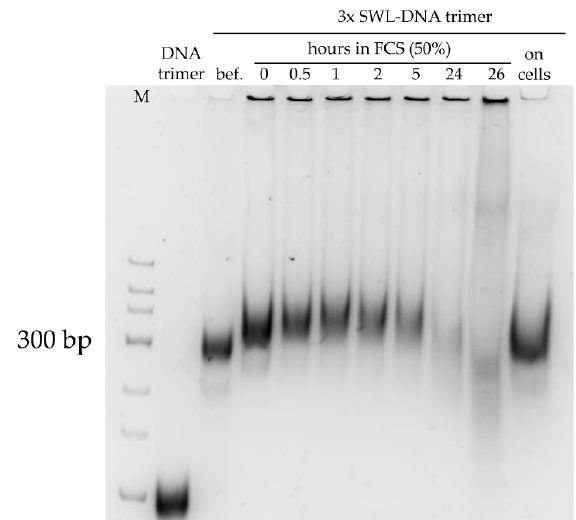
Figure A4. Stability of 3xSWL-DNA trimers in 50% ( v / v ) fetal calf serum (FCS) and incubated with PC-3 cells at 37 °C. Constructs were incubated in 50% ( v / v ) FCS over time, analyzed on 10% ( v / v ) native PAGE and stained with SYBR ® Gold Nucleic Acid Gel Stain. Unmodified DNA trimers serve as control. Sample “bef.” = 3xSWL-DNA trimers before addition of FCS, sample is in 1× PBS/10 mM MgCl 2 . Addition of FCS led to upward shift in gel. Structures were stable over 5 h and degraded after 24 h. When incubated with PC-3 cells in serum-free medium, 3xSWL-DNA trimers were stable for at least 24 h (far right band).